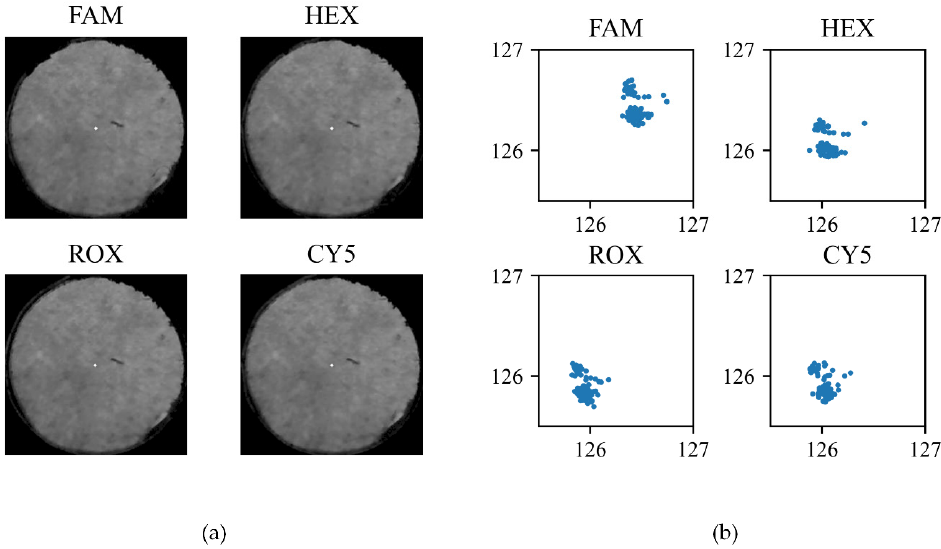
Figure 8. Variation of centroid location for each fluorescence image taken. ( a ) Images taken when each emission filter is aligned with the aluminum base hole. The centroid is represented as a white dot in the image; ( b ) Scatter plot of the centroids for 84 repeats.